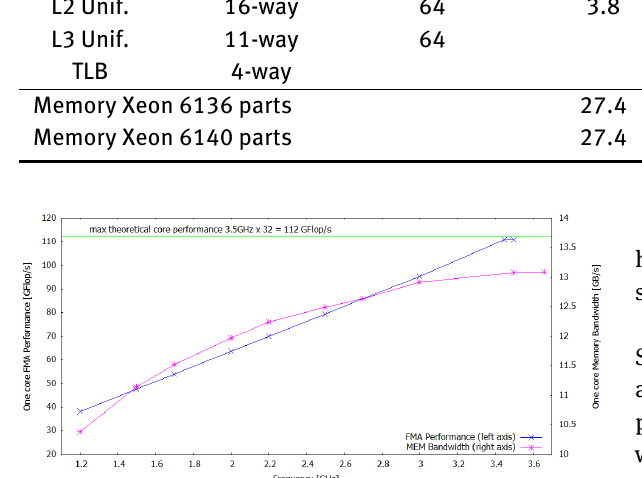
Figure 2: Floating point performance (FMA instructions) on 6136 CPU core and memory bandwidth (STREAM Triad) as a function of clock frequency. Left ordinate shows the FMA performance, the right ordinate represents the memory